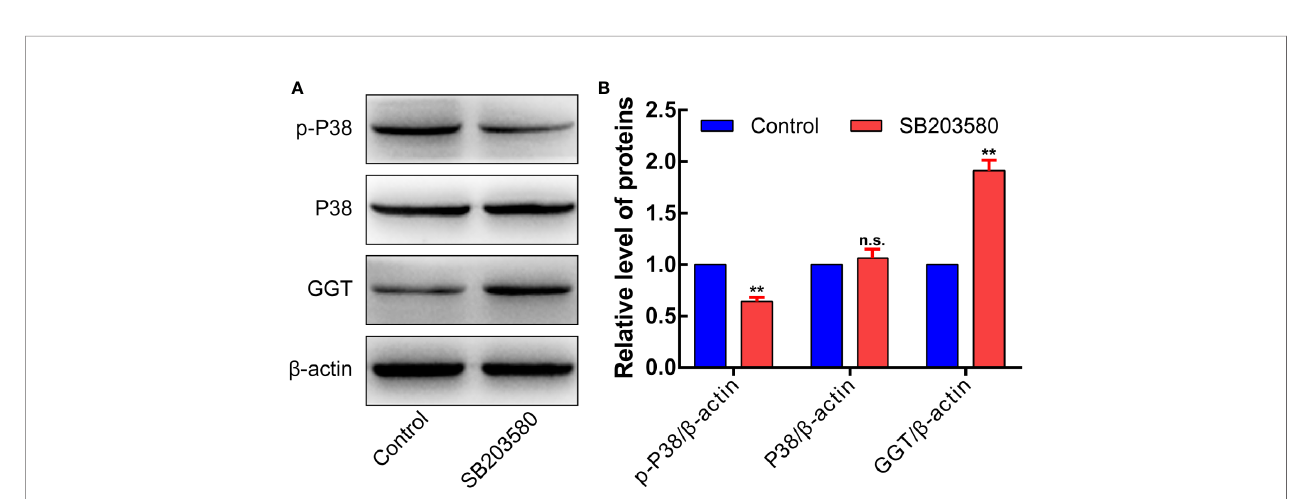
FIGURE 10 | p-P38MAPK is a regulator of the GGT. To further understand how P38 regulates GGT, we treated cells with P38 inhibitors, SB203580 (20 m M), for 24 h. Western blot analysis results showed that the protein levels of p-p38 decreased signi fi cantly, while GGT increased after treatment with SB203580 (Panels 10A, B) .